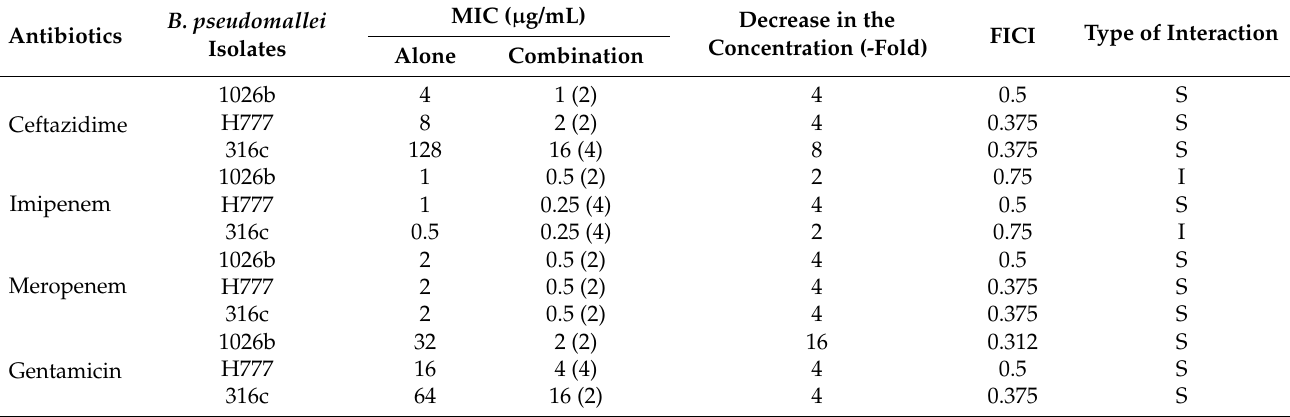
Table 2. Minimum inhibitory concentrations (MICs; µg/mL) of the antibiotics alone or in combination with AgNPs. Fold change in the MIC of the antibiotics in combination or alone.